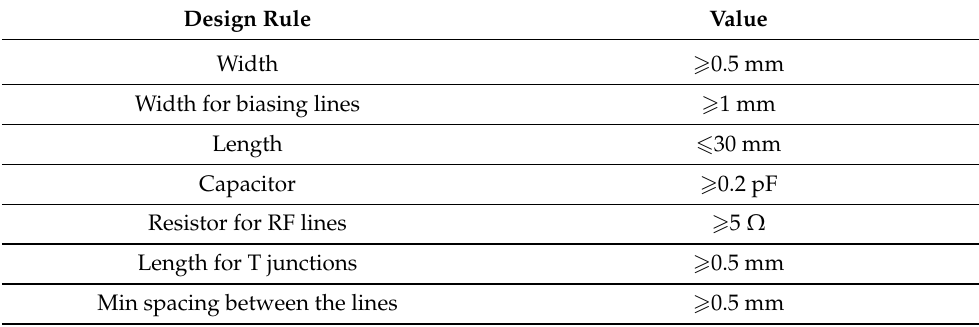
Table 1. Fabrication and design rules for layout and